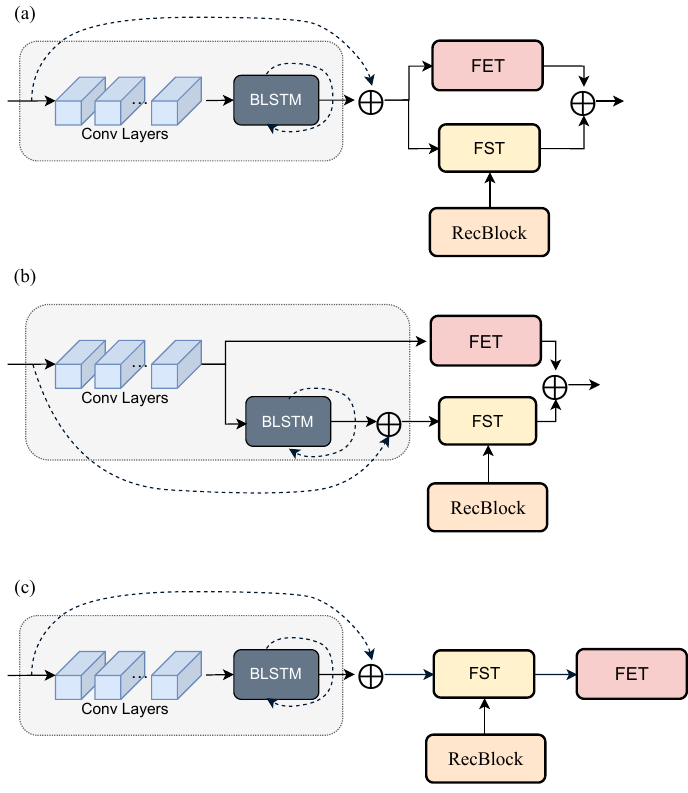
Figure A1. Three architectural of the SR Block: ( a ) CNNs and feature maps via BLSTM are input to FET and FST in parallel, ( b ) clean CNN feature maps without BLSTM are input to FET, and ( c ) FST and FET in